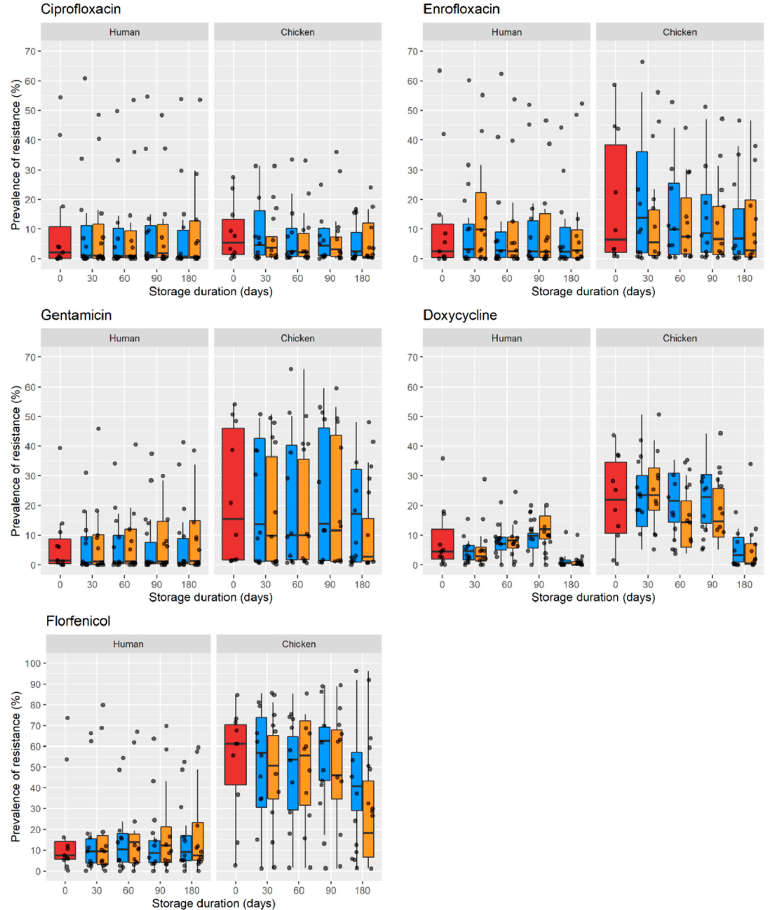
Figure 2. Prevalence of phenotypic AMR among E. coli from human and chicken fresh and freeze- stored faecal samples after 30, 60, 120, and 180 days. Red, fresh sample; blue, − 80 °C; orange, − 20 °C. Table 2. Predictions derived from a Poisson model of the effects of storage duration and tempera- ture on the change in prevalence (%) of phenotypic AMR in human and chicken samples.